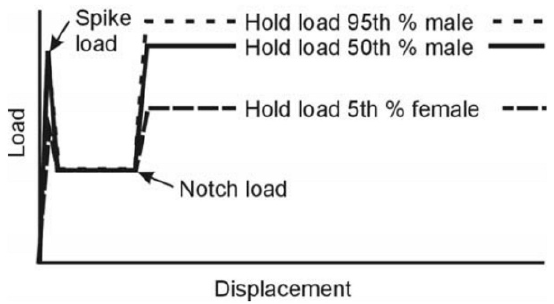
Figure 2. Stroke characteristics of variable-profile energy absorber (VPEA)